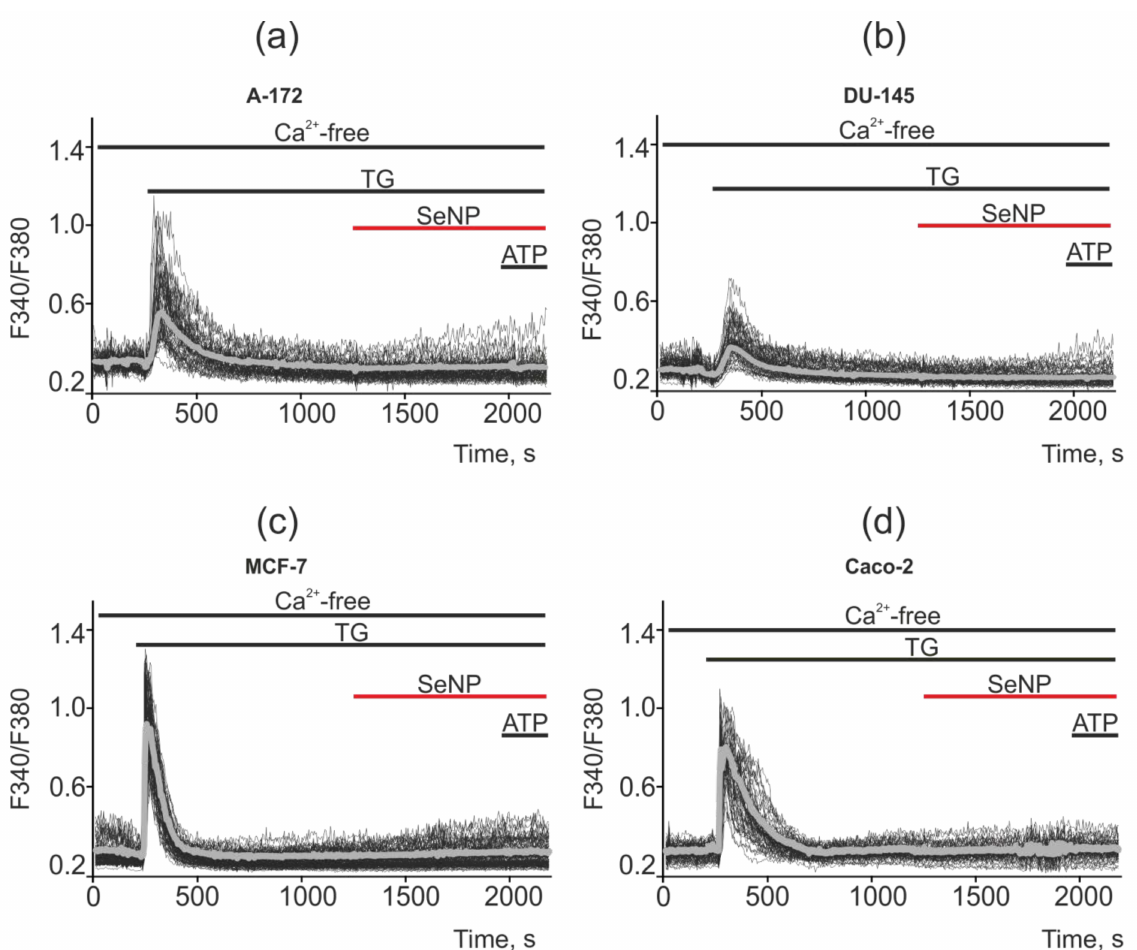
Figure 14. Suppression of Ca 2+ signals in cancer cells in response to application of SeNP after depletion of the Ca 2+ ER pool by adding the SERCA inhibitor thapsigargin (TG, 1 µ M) in a nominally calcium free medium supplemented with 0.5 mM Ca 2+ chelator EGTA. ( a , b ) application of 0.5 µ g/mL SeNP to A-172 and DU-145 cells; ( c , d ) application of 10 µ g/mL SeNP to MCF-7 and Caco-2 cells. The absence of Ca 2+ signals for the application of 10 µ M ATP indicates a complete absence of Ca 2+ entering the outside of the cell and mobilization from the ER. Ca 2+ signals in the field of view of the microscope in one experiment and their average values (gray curves) are presented